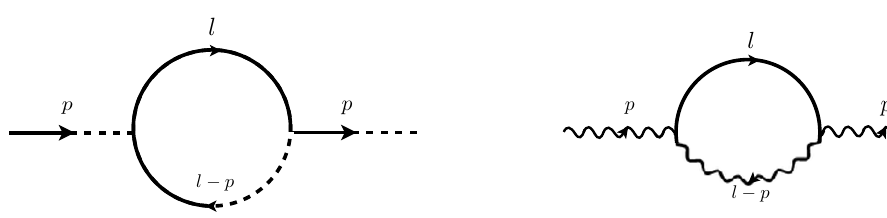
Figure 7 . The Feynman diagrams for the one-loop renormalization of h ϕ ( p ) ω ( − p ) i (left) and h χ i ϕ ( p ) χ j ( − p ) i (right). We have suppressed the i, j